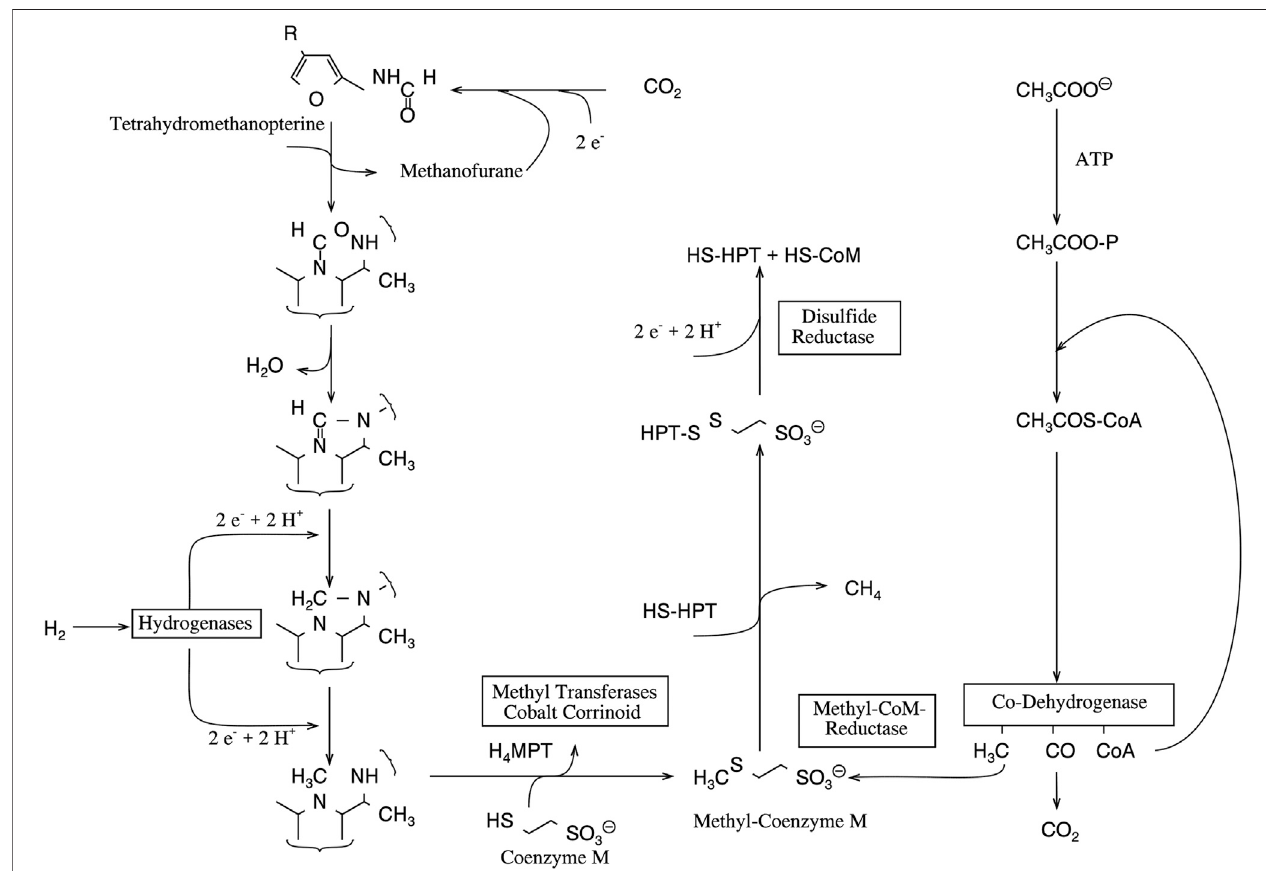
FIGURE 4 | Biological methanogenesis starting from CO 2 and acetate (adapted after Jaun, 1993).